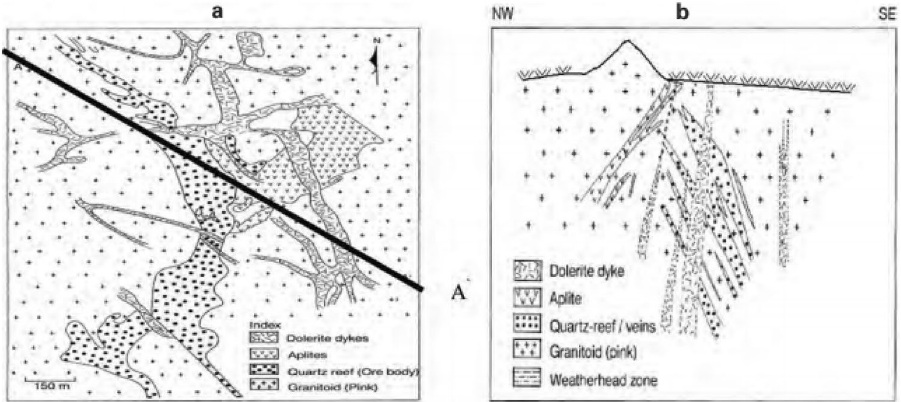
Figure 2. Mine-scale geological map of Malanjkhand copper deposit. ( a ) plain view of different lithotypes ( b ) cross-sectional view of lithotypes along AA ′ 40 .